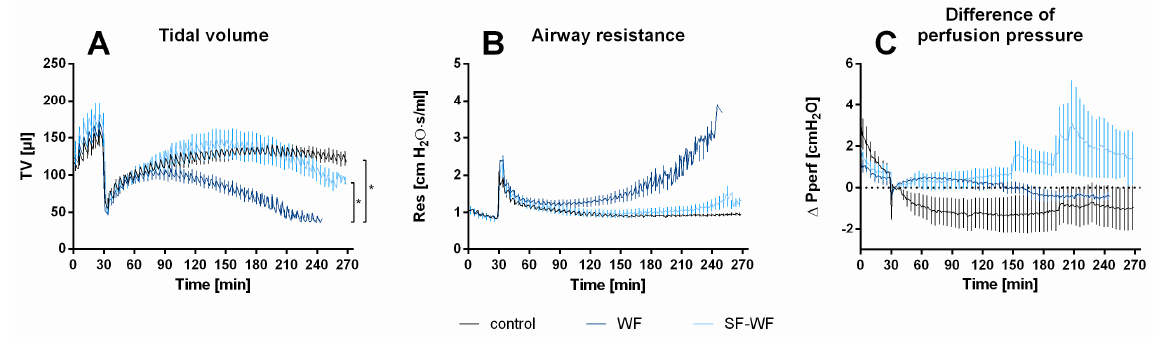
Figure 2. Influence of welding fume instillation on tidal volume, airway resistance and perfusion pressure. ( A ) : Tidal volume. (mean ± SEM); ( B ): Airway resistance (mean ± SEM); ( C ): Difference in perfusion pressure. The difference Δ µL is normalized to the initial value at 30 min. (mean ± SEM); * = p < 0.05, n = 6 per group except WF-SF (n = 5). The statistical analysis was conducted for the interval of 0 to 210 min.